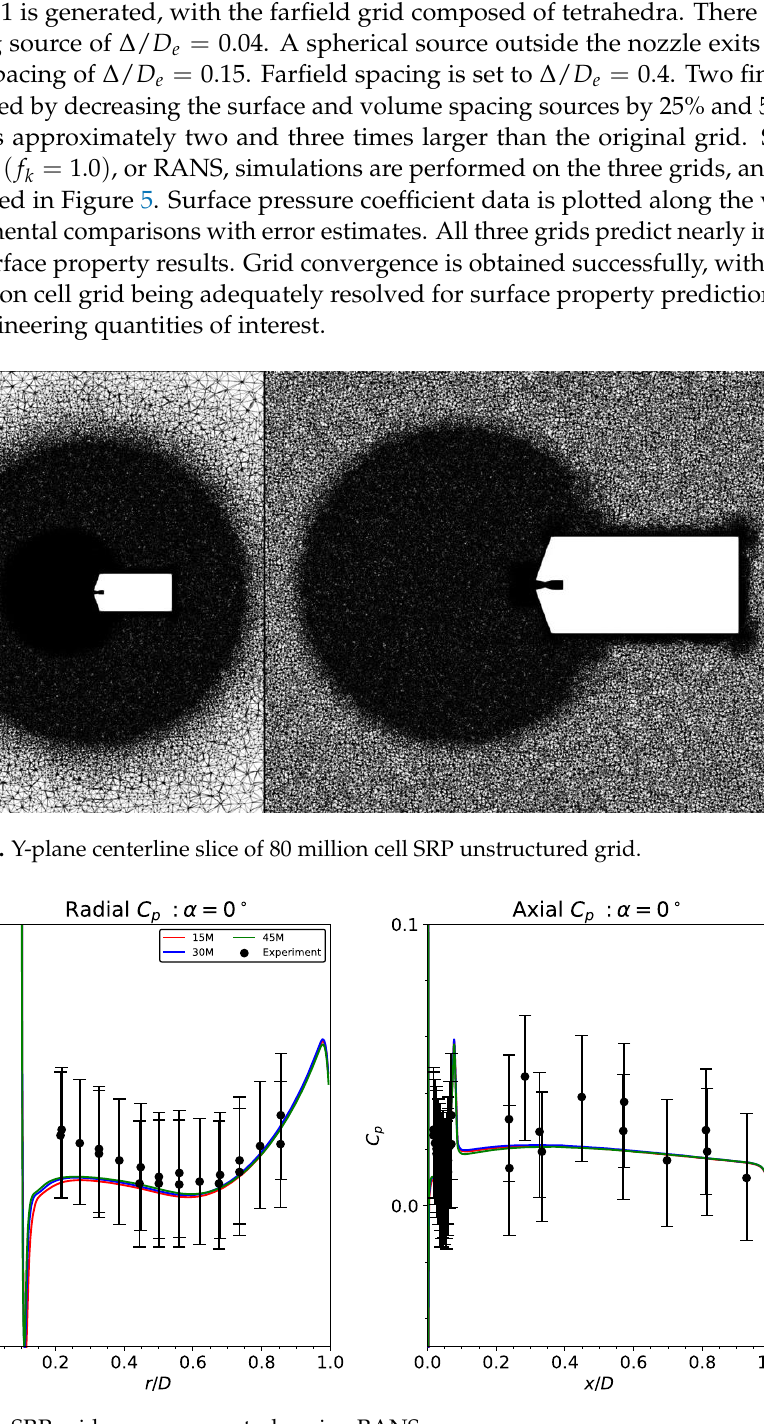
Figure 5. SRP grid convergence study using RANS.